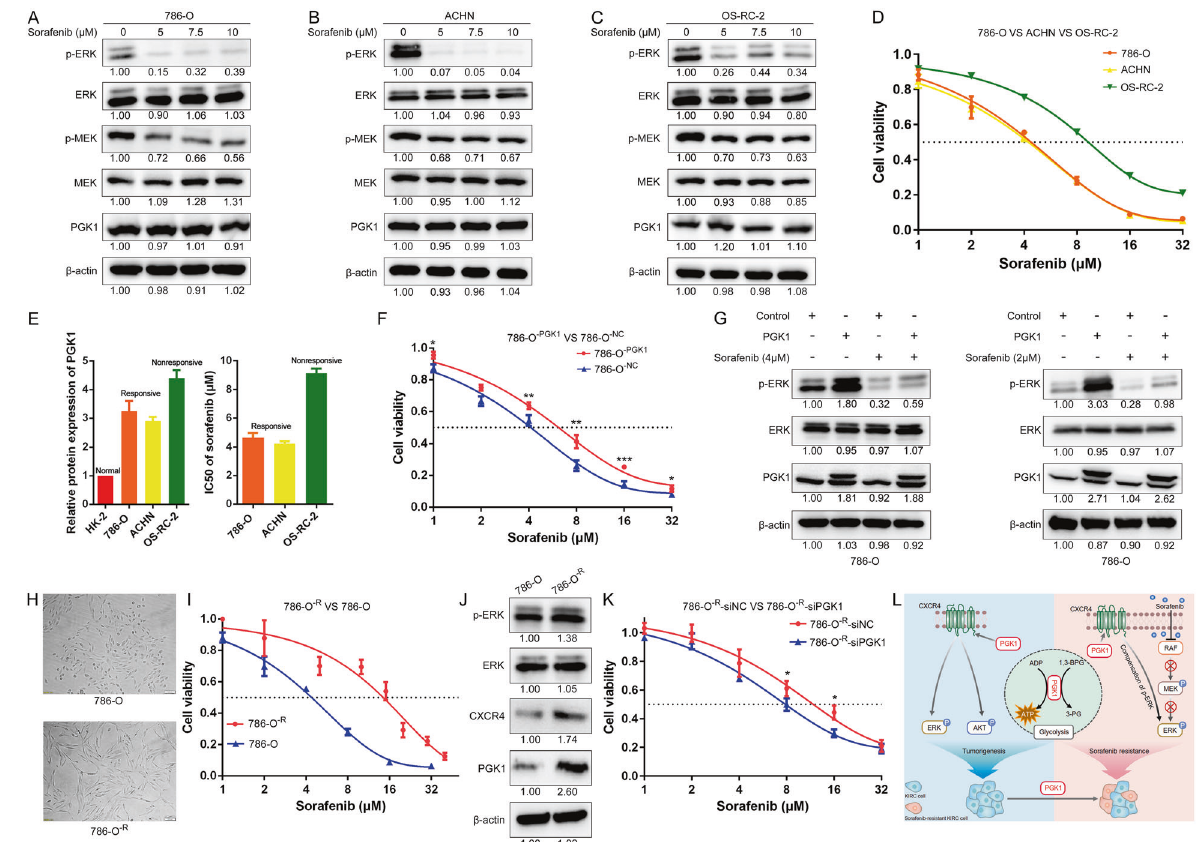
Fig. 8 PGK1 promoted sorafenib resistance via PGK1/CXCR4/ERK signaling. A – C Sorafenib could inhibit Raf/MEK/ERK signaling pathway in all three KIRC cells. After treatment with sorafenib at the same concentration for the same time, the expression of residual phosphorylated ERK was the highest in OS-RC-2 cells. D CCK8 assays of three KIRC cells after sorafenib treatment at the indicated concentrations for 48 h. E Histograms showing the PGK1 protein expression level and IC 50 values (48 h) of three KIRC cells. F CCK-8 assay of PGK1-overexpressing and control 786-O cells after sorafenib treatment at the indicated concentrations for 48 h. G PGK1 promoted sorafenib resistance via increasing ERK phosphorylation in 786-O cells. H Schematic diagram of morphological differences between sorafenib-resistant 786-O cells and wild-type 786-O cells. I CCK-8 assay of sorafenib-resistant 786-O cells after sorafenib treatment at the indicated concentrations for 48 h. J Expression levels of PGK1, CXCR4, ERK and its phosphorylation were detected in sorafenib-resistant 786-O cells and wild-type 786-O cells. K Interference with PGK1 expression in our constructed 786-O -R cells increases their sensitivity to sorafenib. L Schematic diagram of the PGK1-invovled signaling pathway in KIRC progression and sorafenib resistance. In addition to promoting glycolysis to produce ATP for energy supply, PGK1 also induced CXCR4-mediated activation of AKT and ERK phosphorylation to promote tumor growth. Since the RAF/MEK/ERK signaling pathway is one typical target of sorafenib, PGK1 promoted sorafenib resistance via not only accelerating glycolysis but also compensating for the inhibition of ERK phosphorylation caused by